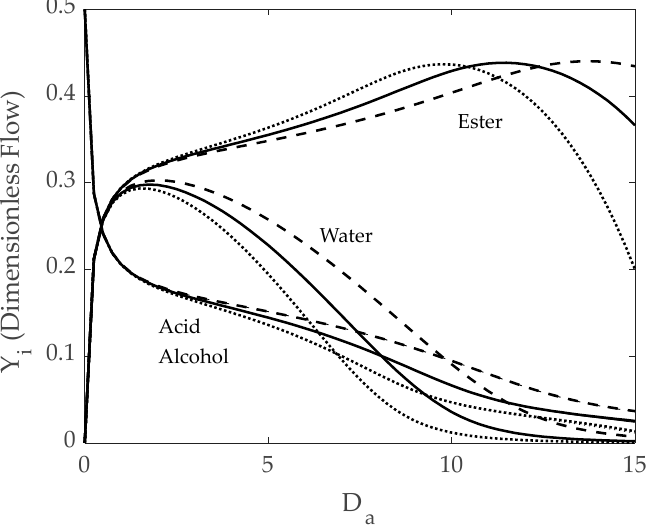
Figure 10. Dimensionless species outlet flows in a ISPVMR, in the retentate side, as a function of the D a for: a) Ω = 0. 022 (dashed spacing), b) Ω = 0. 03 (solid line), and c) Ω = 0.035 (dotted line), delivering ester with less purity than for the IFBPVMR. Note: Isoamyl alcohol and acetic acid symbols superimpose each other given that the selected stochiometric ratio at feed conditions is 1.